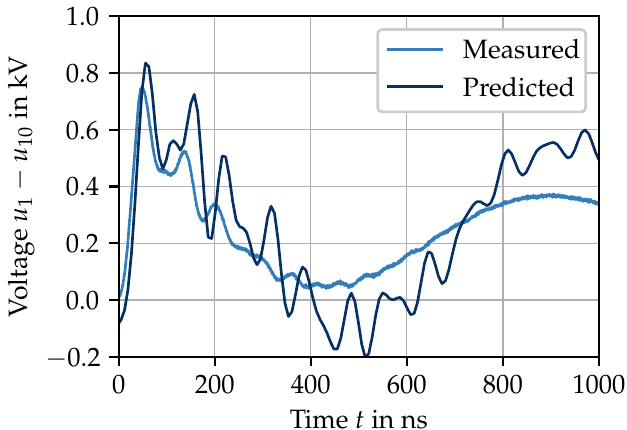
Figure 14. Voltage difference over the first ten turns of stator specimen S3, measured and predicted. Figure 14. Measured and predicted voltage over the first ten turns of stator specimen S3 Finally, the potential distribution is presented in Figure 15.